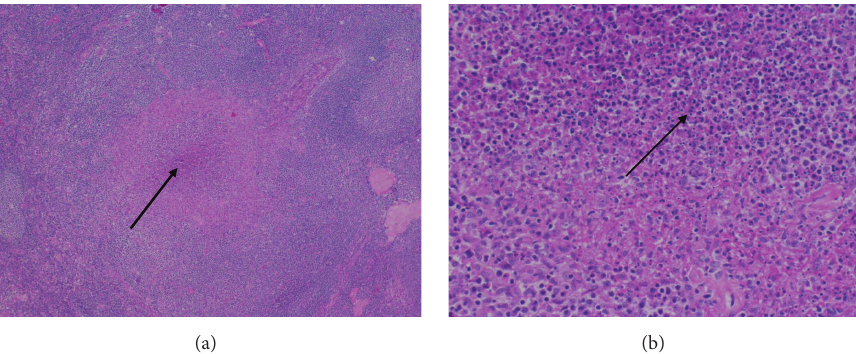
Figure 1: (a) HE, 4x: lymphadenitis with follicular hyperplasia and necrosis (arrow) surrounded by a histiocytic reaction. (b) HE, 20x: necrotizing and granulomatous lymphadenitis, with numerous neutrophils cells (arrow).